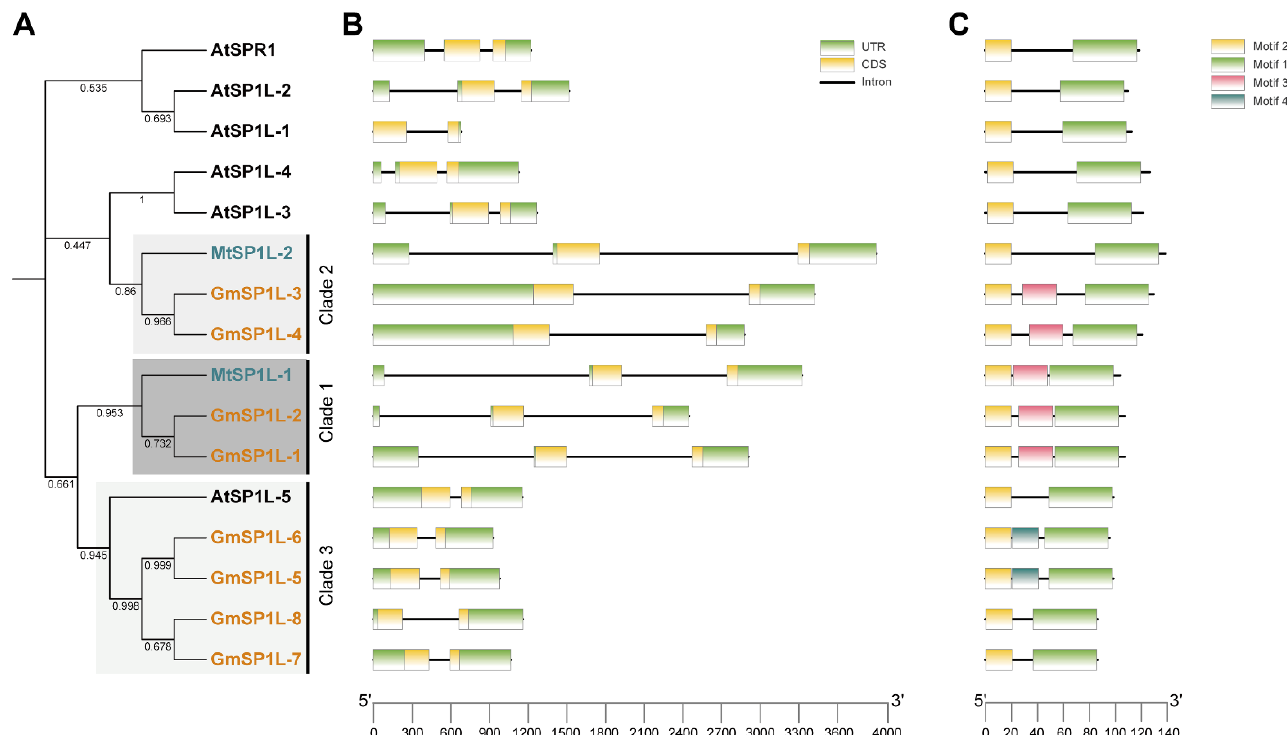
Figure 3. Phylogenetic relationships, gene structures, and motifs of the SP1L genes from A. thaliana , M. truncatula, and G. max ( A – C ). The clades and colors of the phylogenetic tree are the same as in Figure 1. The green boxes in ( B ) indicate 5′ - and 3′ - untranslated regions, the yellow boxes indicate exons, and the black lines indicate introns. The motifs are indicated in different colored boxes with different numbers, and the sequence information for each motif is provided in Supplementary Figure S3.